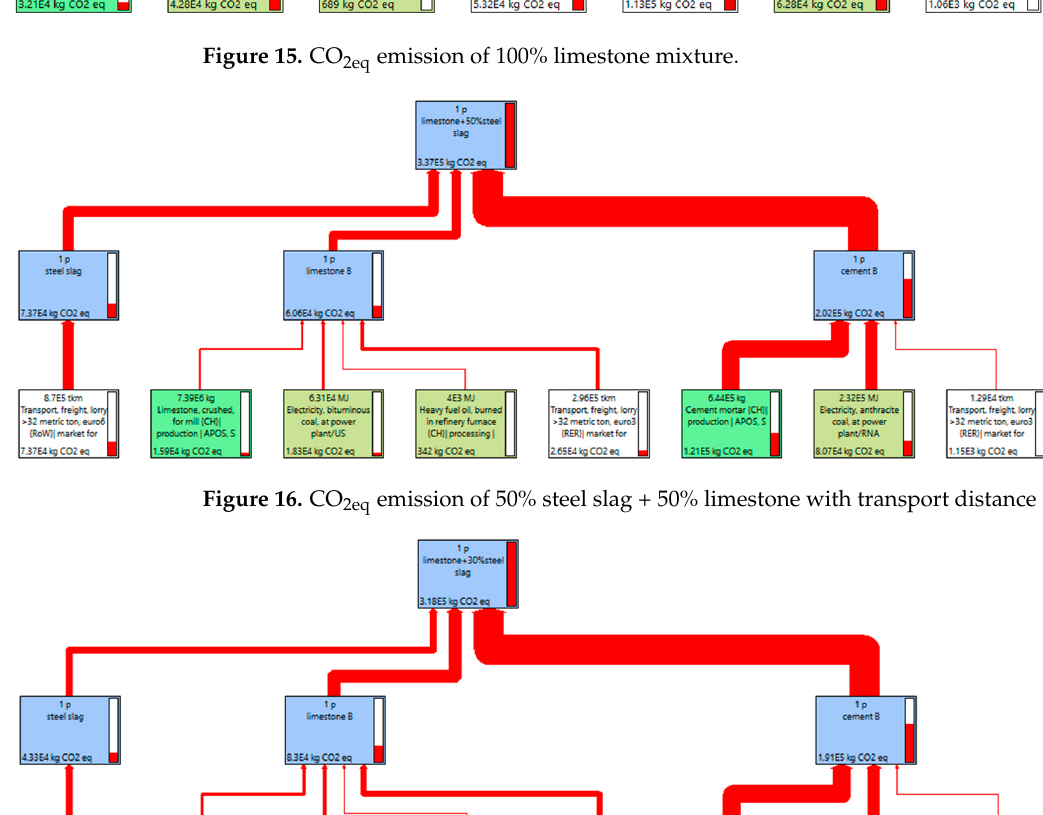
Figure 18. Detailed CO 2eq emissions for each procedure. 5. Conclusions Steel slag is a promising alternative for natural aggregates in pavement base course. In this study, different steel slag content (0%, 30%, 50%, 75%) was added to cement-treated aggregates. Throughout investigations including mechanical properties, volume charac- terization, economic benefits and environmental impacts, main conclusions are as follows: (1) Compared to traditional mineral aggregate (i.e., limestone), steel slag aggregate has equal or superior engineering properties, including density, abrasion resistance and crushing resistance. Due to higher water absorption and larger gravity, the OMC and MDD increase proportionally as more natural aggregates are replaced with steel slag. (2) Mechanical properties including strength and stiffness are significantly improved by steel slag within 50% replacement due to the increased hydration products and in- terlocked aggregate structure. However, the porosity and water absorption rate have greater negative effect on strength when steel slag replacement further increases. 43300